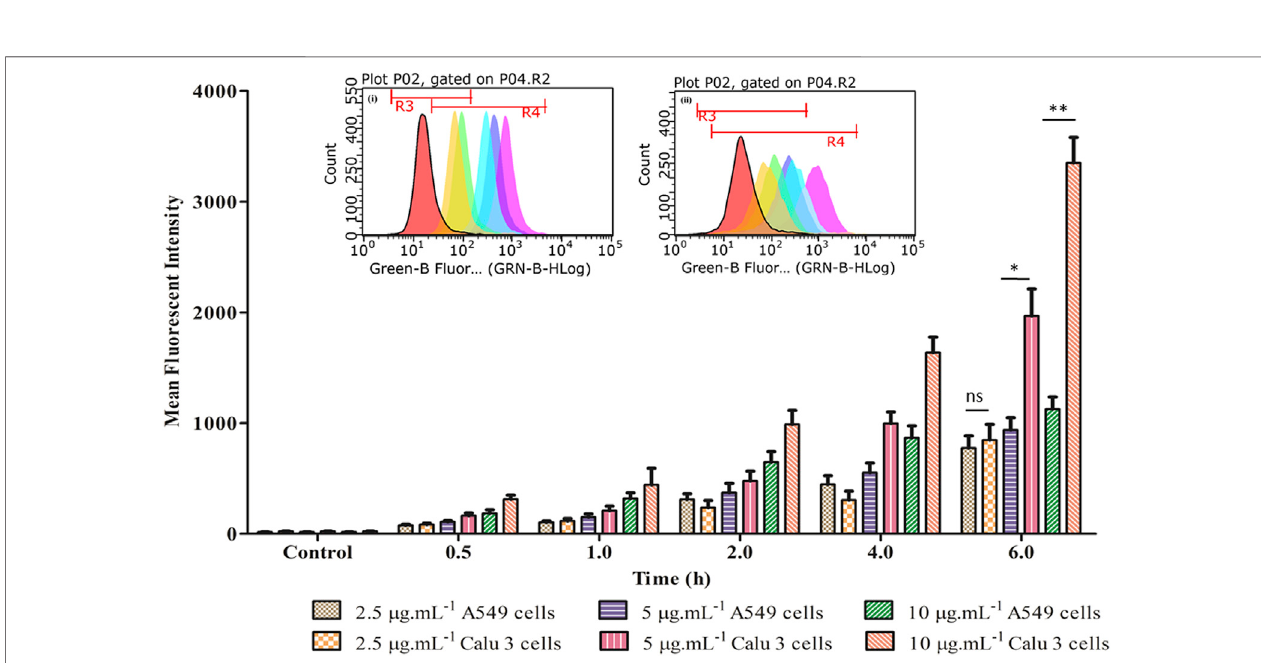
FIGURE 8 | Time- and concentration-dependent pro fi le of fl uorescent intensity of LNVs in A549 and Calu 3 cells. The corresponding inset displays the fl ow cytometry data of LNVs (2.5 μ g ml − 1 ) for a time duration of 6 h in (i) A549 and (ii) Calu 3 cell lines, respectively. Data represent mean ± SD values ( n (cid:2) 3). The asterisks represent statistically signi fi cant difference (* p < 0.01, ** p < 0.0001), while “ ns ” indicates an insigni fi cant ( p > 0.05) difference between the groups tested.